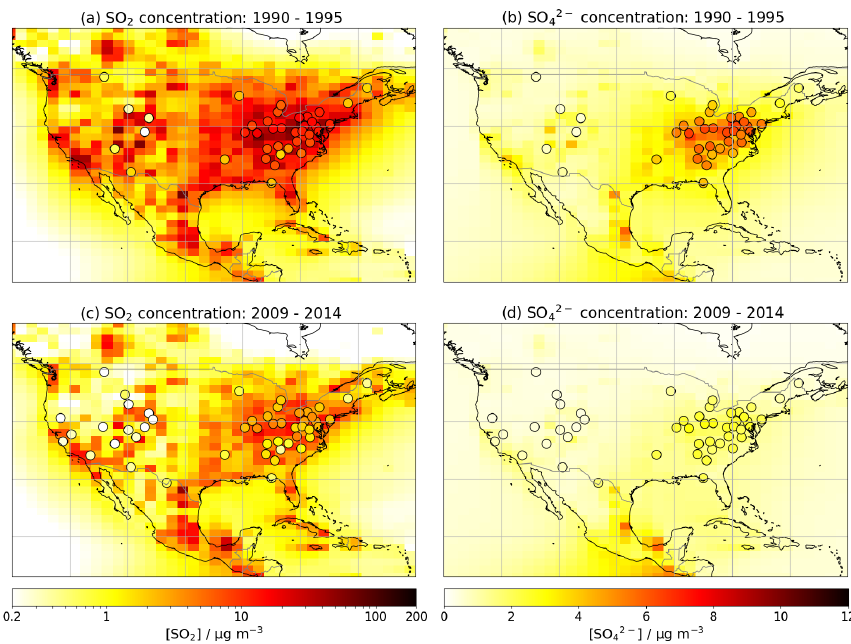
− concentration (b, d) for 1990–1995 (a, b) and 2009–2014 (c, d) 4